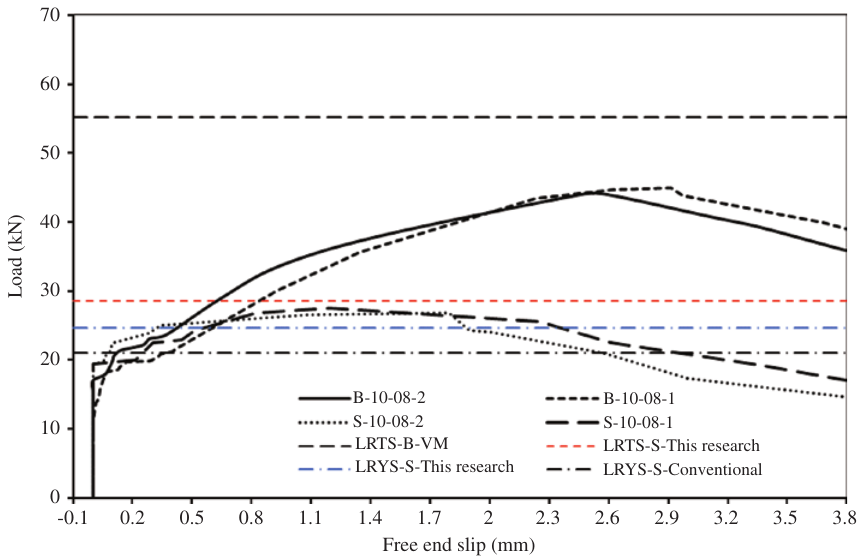
Figure 12: Load and free end slip relationship of 8 mm reinforcement bars and concrete (10 Φ embedment length).